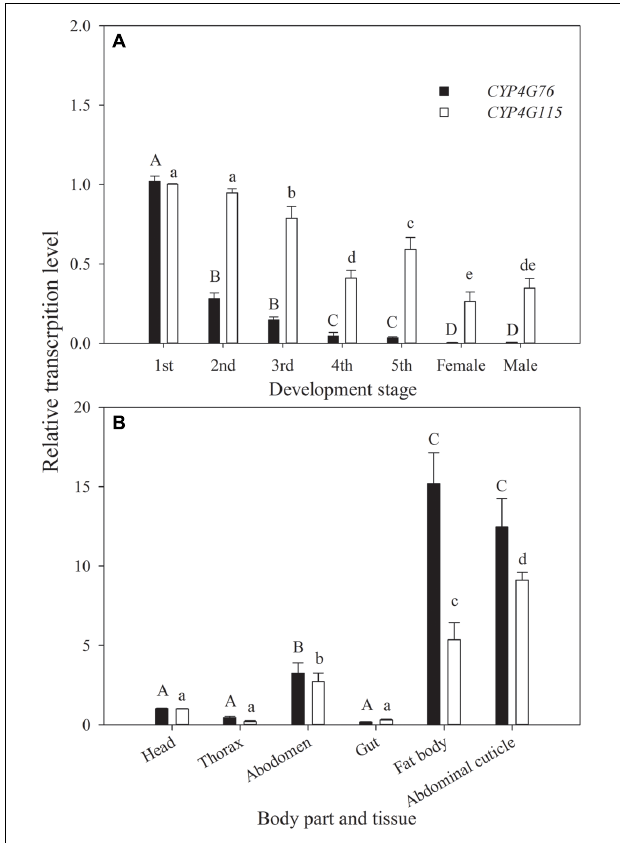
FIGURE 1 | (A) Relative expression levels of CYP4G76 and CYP4G115 across developmental stages of Nilaparvata lugens , and (B) relative expression levels of CYP4G76 and CYP4G115 in different body parts or tissues of N. lugens . Mean ± SE was calculated from five biological replicates, and each biological replicate contained ten N. lugens nymphs or adults. Capital letters indicate significant differences between instar stages of CYP4G76 , and lowercase letters indicate significant differences in instar stages of CYP4G115 (ANOVA, LSD, p < 0.05).